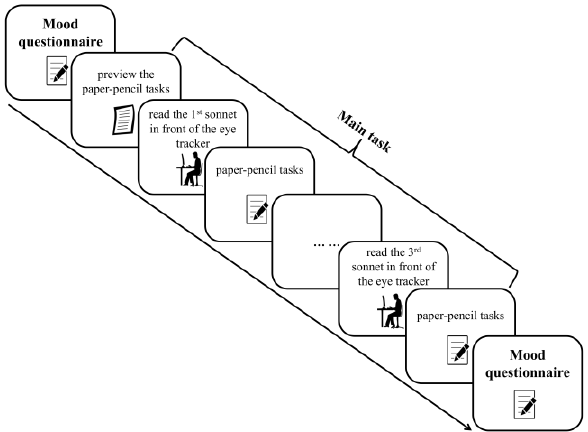
Figure 1 . The Procedure of the Experiment. An English translation of the German multidimensional mood questionnaire (MDBF; Steyer et al., 1997) was presented to the participants before and after the main tasks to evaluate whether sonnets reading induced longer-lasting changes in participants’ mood state. The data acquisition for each sonnet was split in two parts: first initial reading of the sonnet with eye tracking and the following paper-pencil tasks. After answering the questionnaire for the first sonnet, participants continued with reading the second sonnet in front of the eye tracker and so on. The order of the three sonnets was counterbalanced across participants. In order to make the reading of the first sonnet comparable to the reading of the latter two, participants became acquainted with a questionnaire example before the initial reading of the first